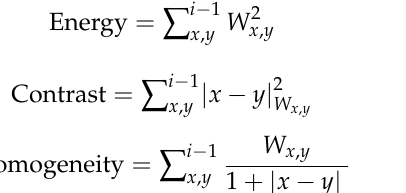
Table 1. Faults of PV panels.